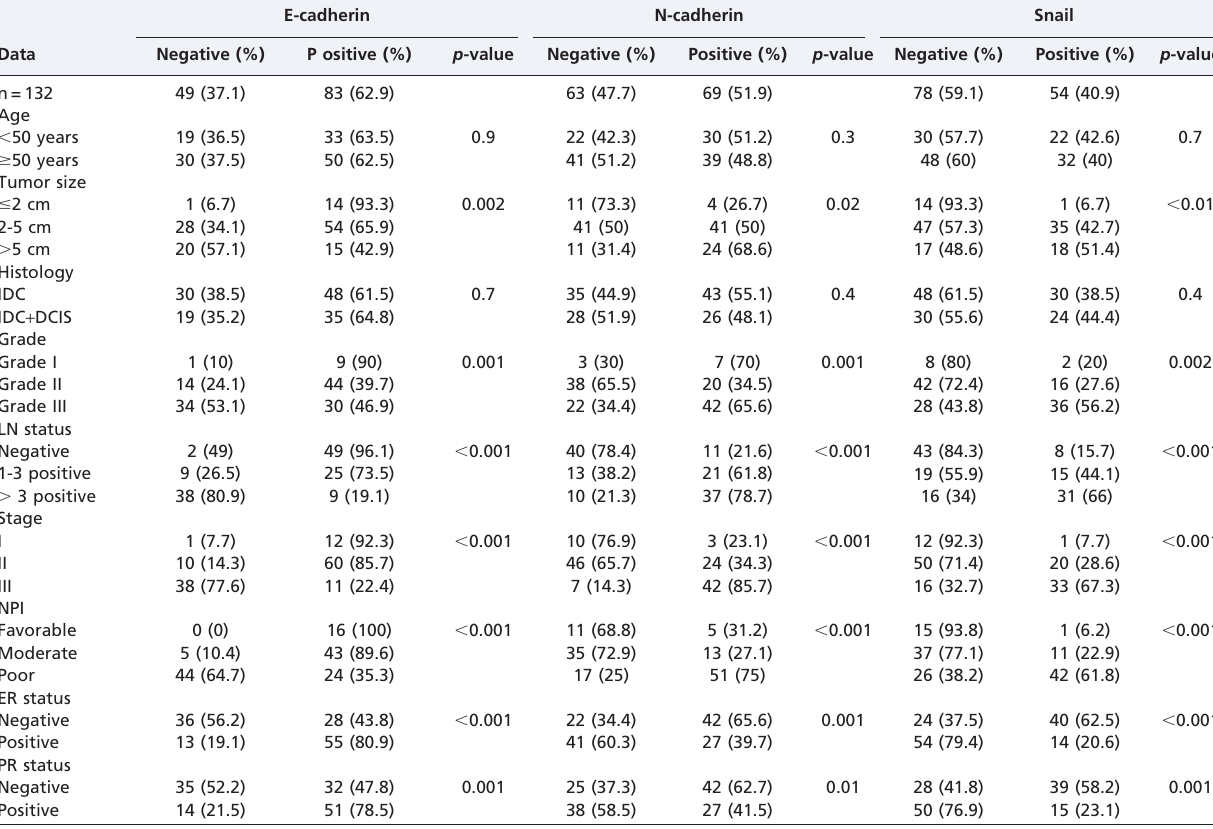
Figure 1 - ( A ) Immunohistochemical expression of E-cadherin was detected in normal breast glands. The luminal cells of the terminal ductules exhibit cytoplasmic membrane (linear intercellular) immunoreactivity, while no staining of the myoepithelial cells at the basal side of the epithelium was observed (X 400). ( B ) Immunohistochemical staining for E-cadherin in invasive ductal carcinomas of the breast. A well-differentiated tumor (grade I) showing strong cytoplasmic membrane staining localized almost exclusively to areas of cell–cell junctions is shown (X 400). ( C ) Poorly differentiated infiltrating ductal breast carcinomas (grade III) immunostained for E- cadherin, showing reduced and heterogeneous staining (X 400). Table 2 - Expression of E-cadherin, N-cadherin and Snail in 132 invasive ductal breast carcinomas and their correlations with clinicopathological features.